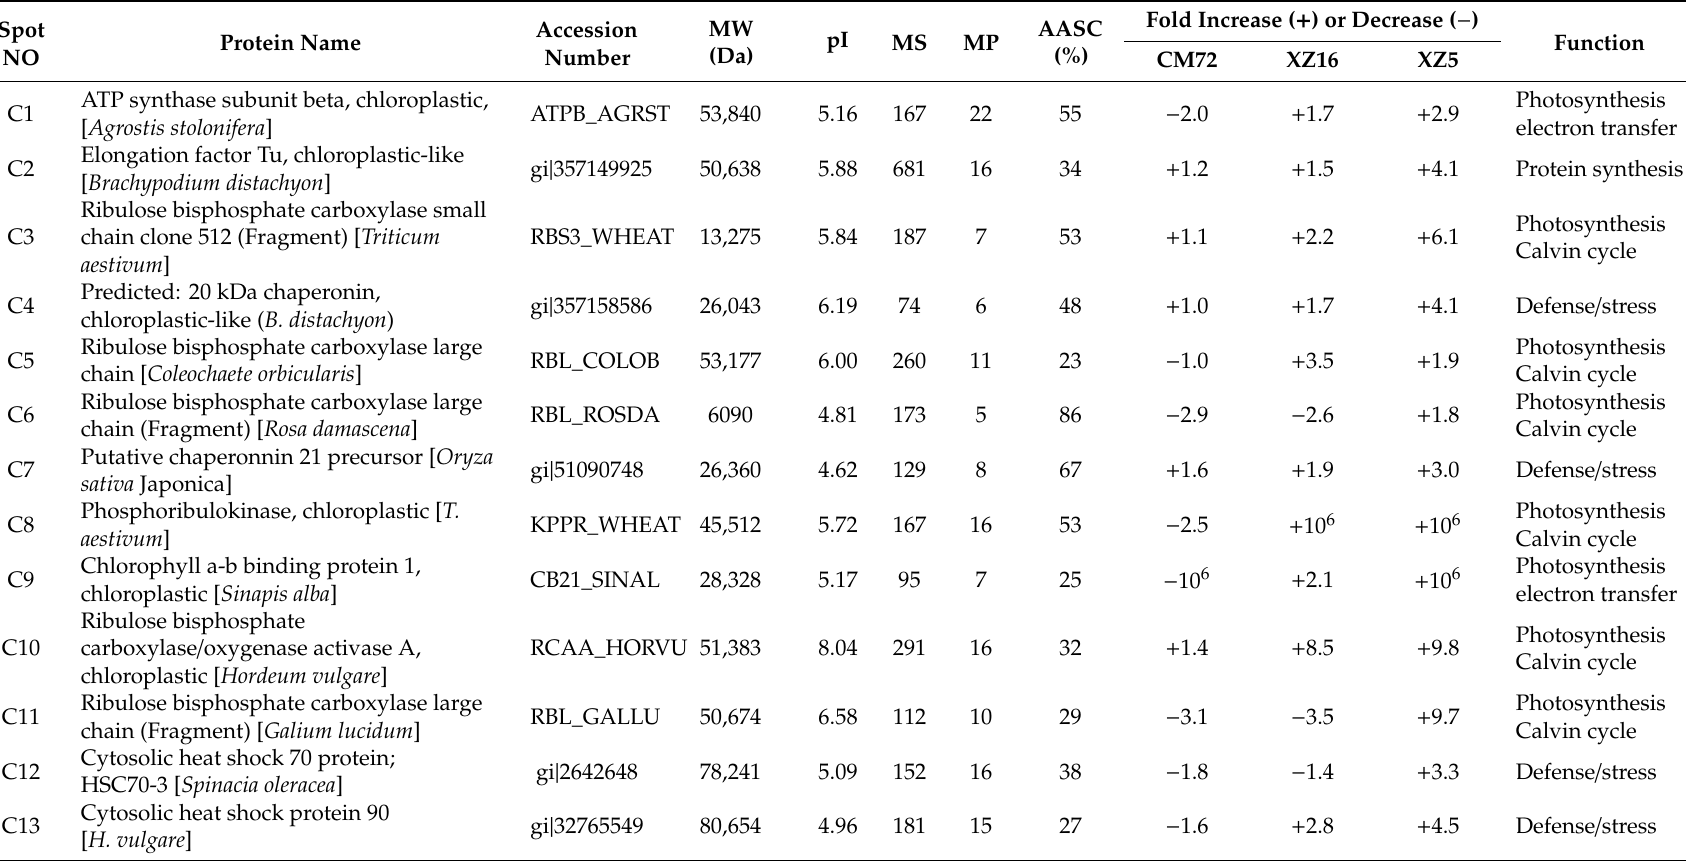
Table 1. Proteins expression under D + S vs. drought stress: Proteins induced in XZ5 leaves ( + ) but downregulated ( − ) / unchanged in CM72, or unchanged in XZ5 but downregulated in CM72. (Uploaded: http: // www.peptideatlas.org / PASS / PASS01597 Dataset tag: